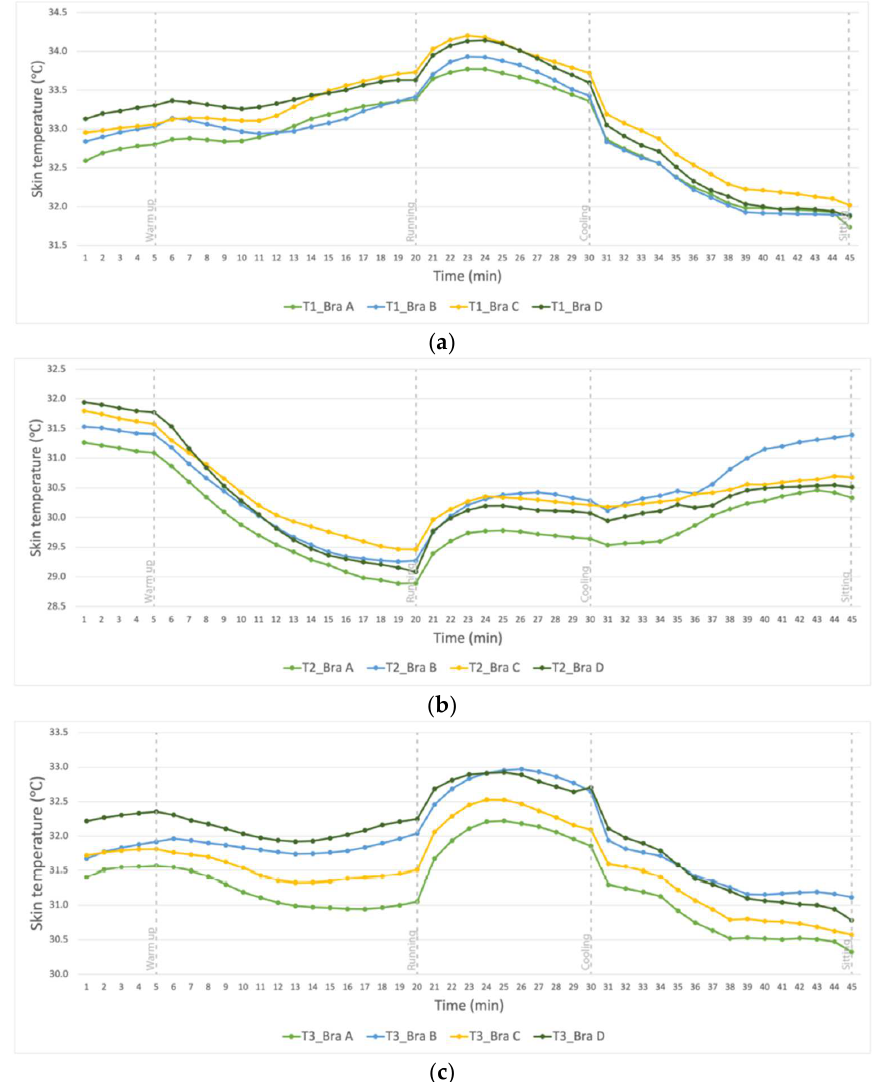
Figure 6. Changes in skin temperature in Stages 0 to IV of treadmill exercise at ( a ) right breast (T1) ( b ) abdomen (T2) and ( c ) mid-back (T3). ( b ) abdomen (T2) and ( c ) mid-back (T3).